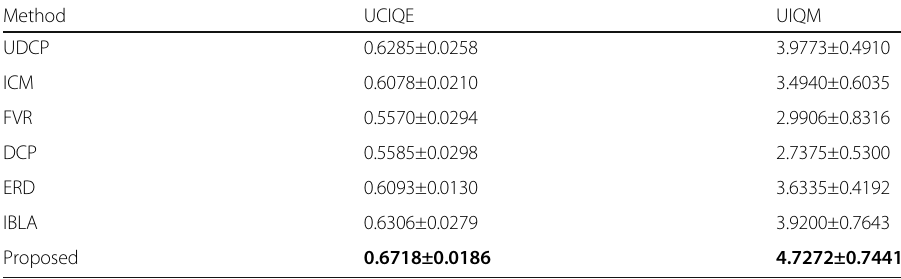
Table 4 Performance comparison based on top 50 best underwater image restoration